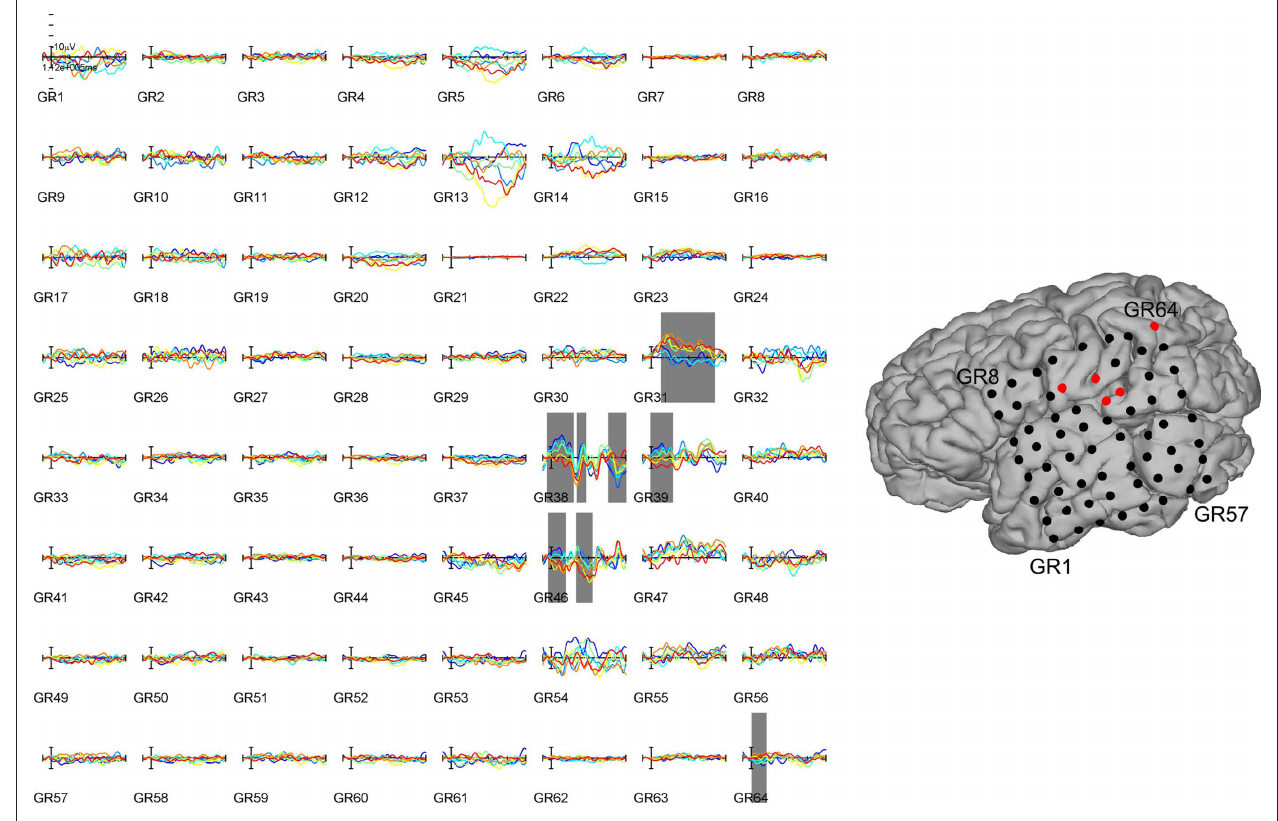
Figure A3 | evoked potentials from S8 across the seven ∆ F conditions used for this